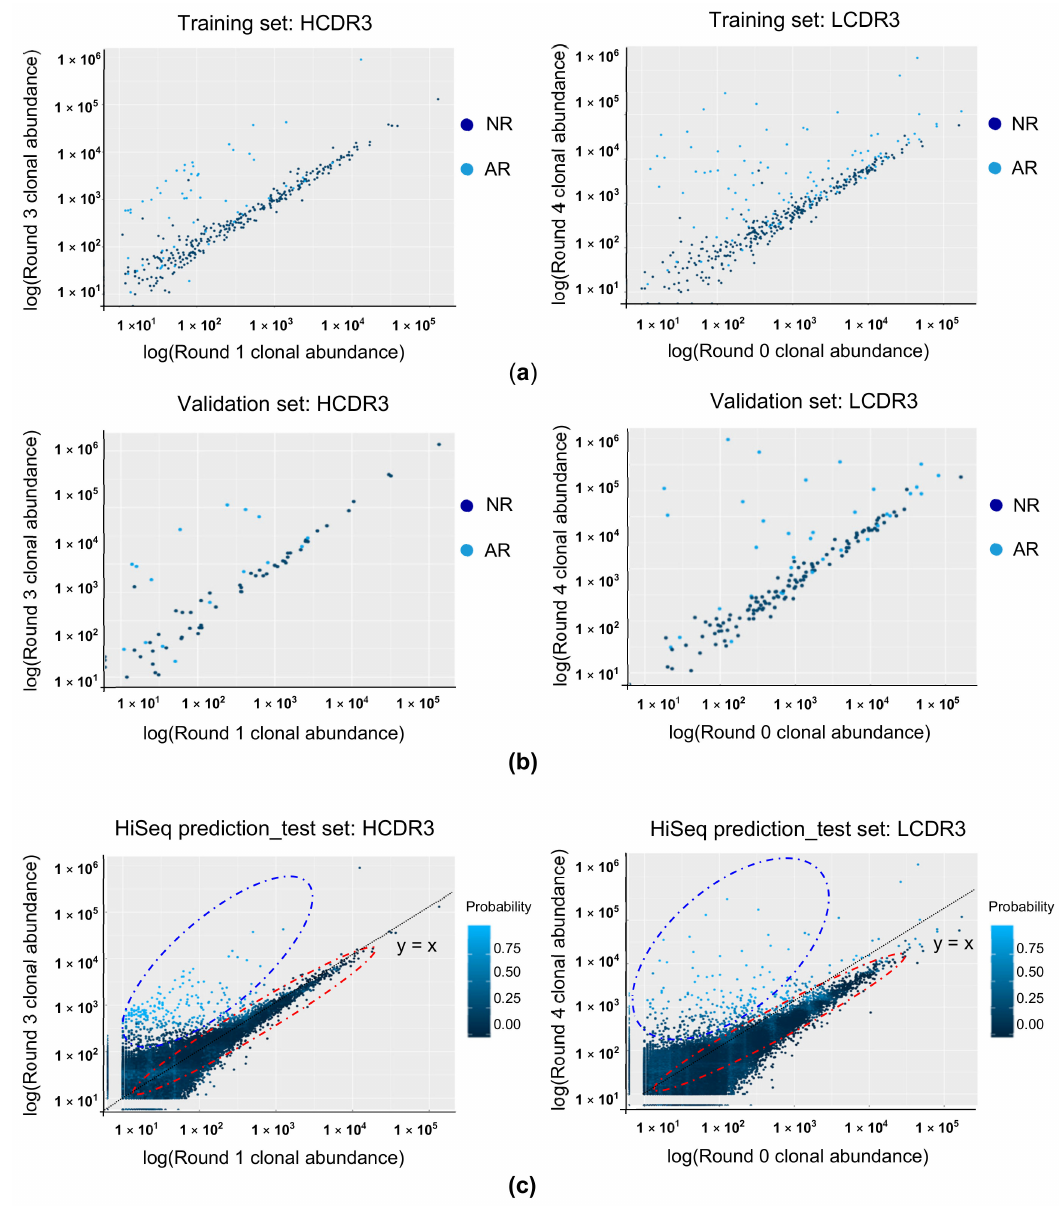
Figure 3. The most influential variable interactions and distributions of CDR3 clonotypes. ( a ) Clonal abundance at the most influential interaction is plotted with binding property label from training data used in the random forest (RF) prediction model. AR, antigen-reactive, NR, antigen non-reactive. ( b ) Clonal abundance at the most influential interaction is plotted with a binding property label from validation data used in the RF prediction model. ( c ) Clonal abundance at the most influential interaction is plotted with confidence value (probability) from HiSeq-identified CDR3 clonotypes. Clonotypes with higher confidence values are distributed near the root variable axis (highlighted with a dashed blue circle) while clonotypes having lower confidence values are distributed below the y = x axis (dotted line) (highlighted with a dashed red